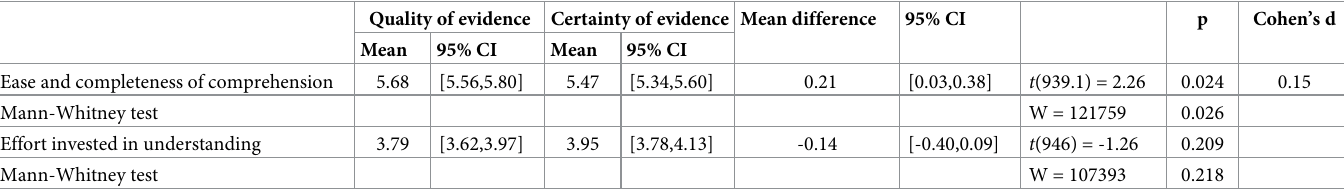
Table 5. Quality versus certainty of evidence wording on understanding (Experiment